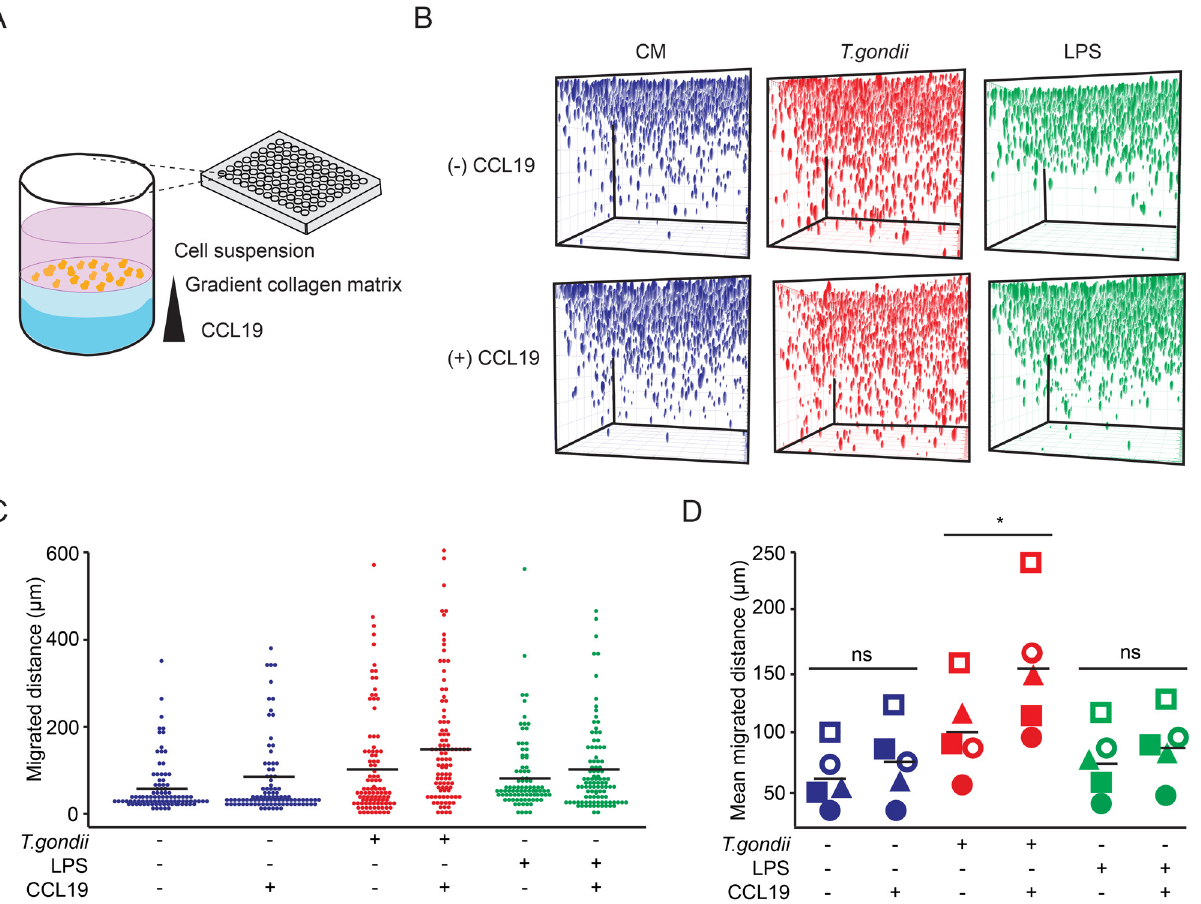
Fig 5. Chemotaxis and hypermigration of Toxoplasma -infected DCs in a 3D matrix. ( A ) Schematic representation of the assay set-up with CCL19 added in the lower collagen matrix (dark blue). Cells were deposited onto the upper collagen matrix (light blue) as indicated under Materials and Methods. DCs were maintained in CM, pre-challenged with T . gondii (PRU-RFP, type II) or treated with LPS (final concentration 100 ng/ml) and deposited on top of the collagen layer in 96-well plates. After 24 h incubation, the localization of DAPI-labeled DCs in the gel was analyzed in 200 z-sections. ( B ) Plots indicate the assembly of z-stacks and colored structures indicate the localization of DCs in absence or presence of CCL19. ( C ) Dot plots represent the distribution of migrated distances for the different conditions. For each condition, 100 randomly chosen cells were analyzed from one representative donor. Performed with 5 donors with similar result. ( D ) Mean migrated distances of cells under same conditions as in B and C. Data represent compiled analysis of 500 randomly chosen cells per donor from 5 different donors. Bars indicate mean migrated distances. ( * : P < 0.05, ns: P > 0.05; Paired t -test, Holm´s